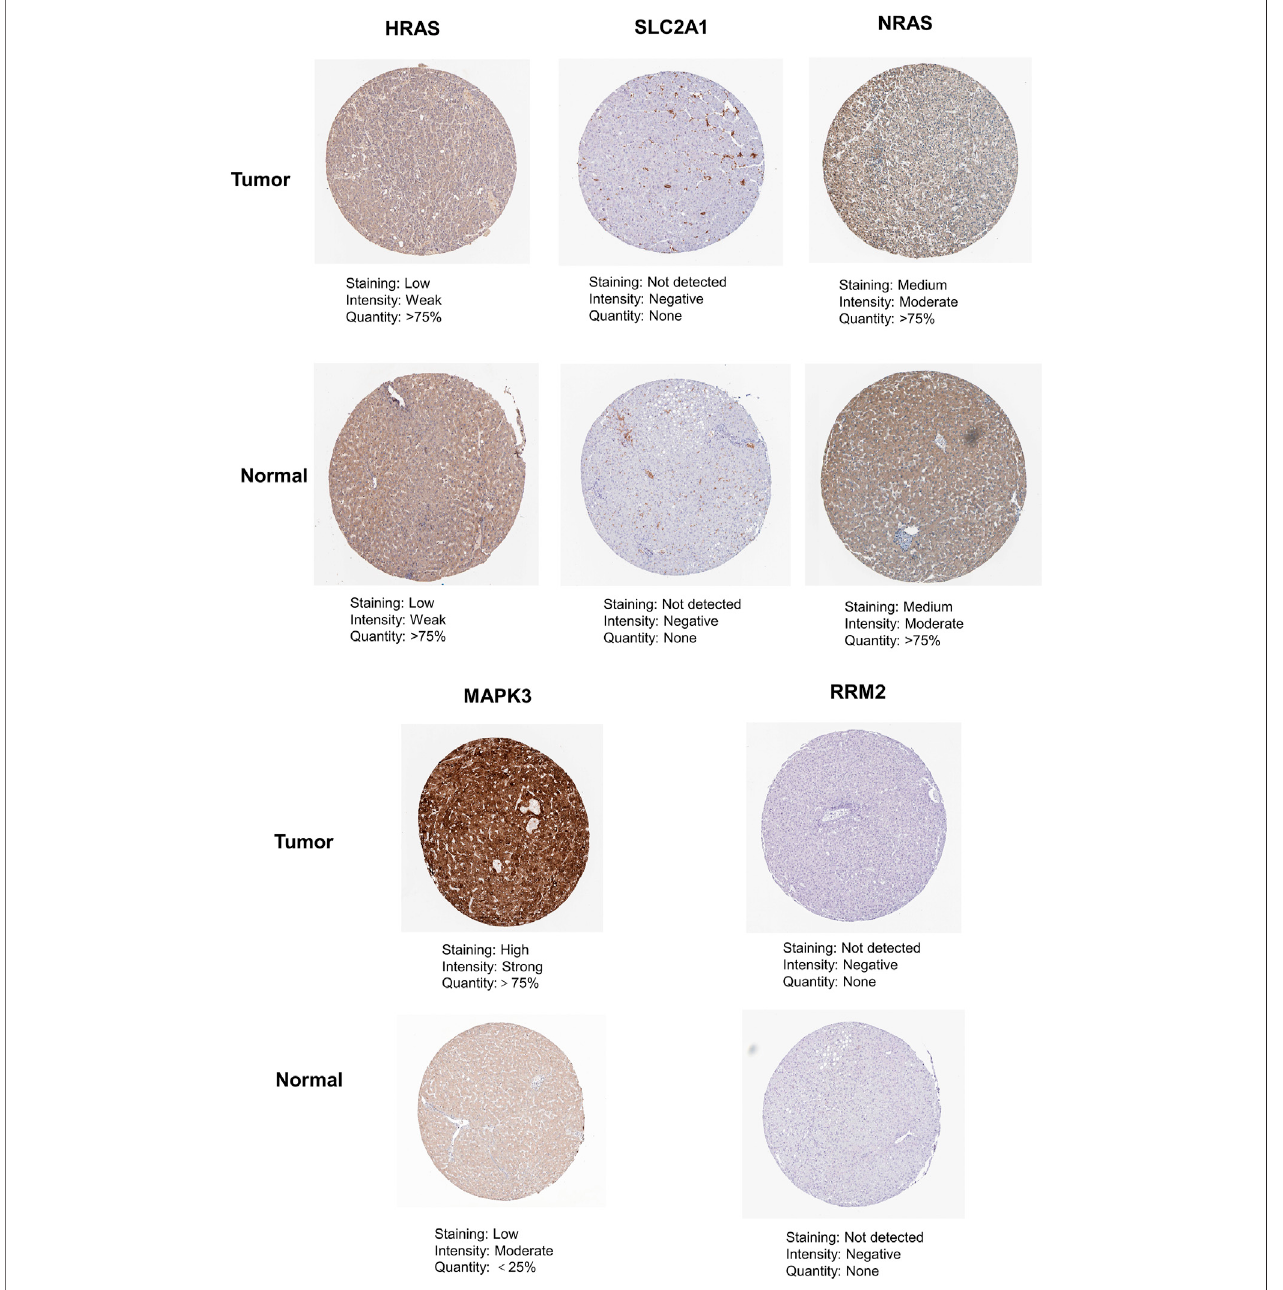
FIGURE 12 | The immunohistochemistry images of related hub genes from the HPA database in liver cancer tumor tissue and normal tissues.